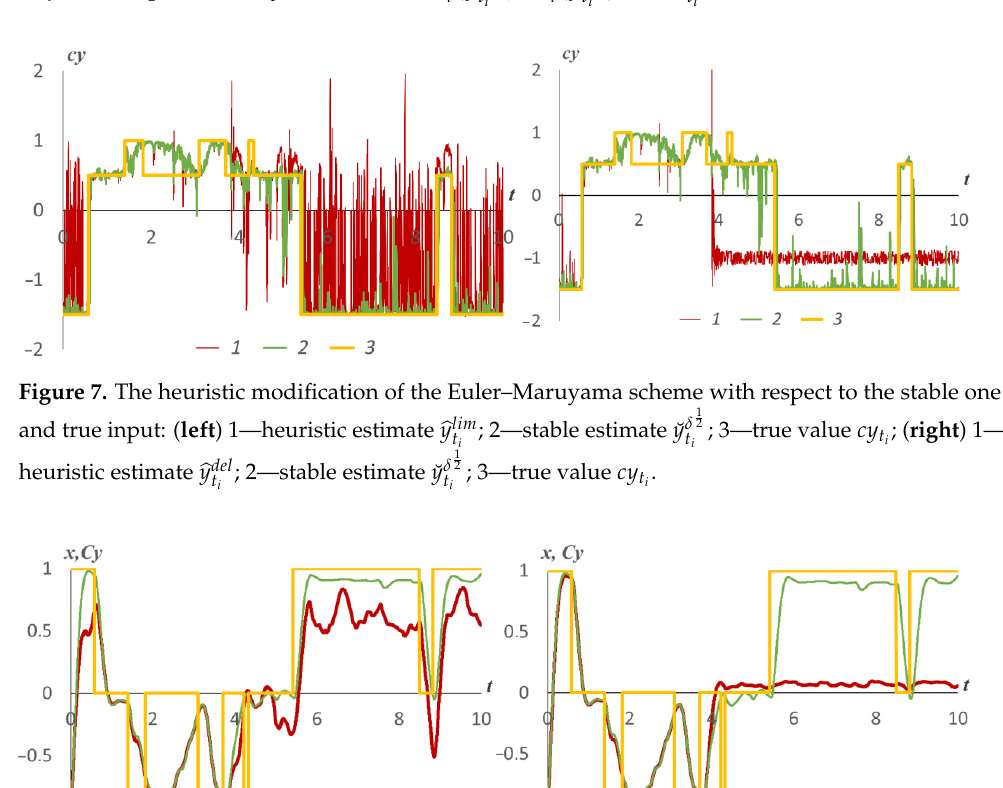
1 2 ; 3—drift Cy t ; ( right ) 1—system state, controlled by t i i 1 2 ; 3—drift Cy t t i i